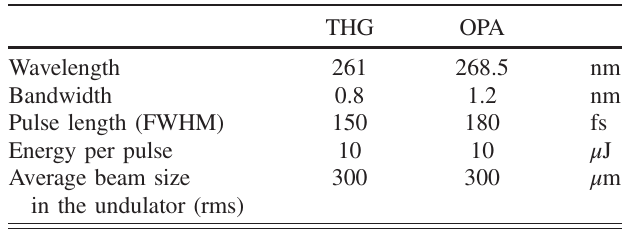
TABLE I. Parameters characterizing the electron beam used in the experiment.